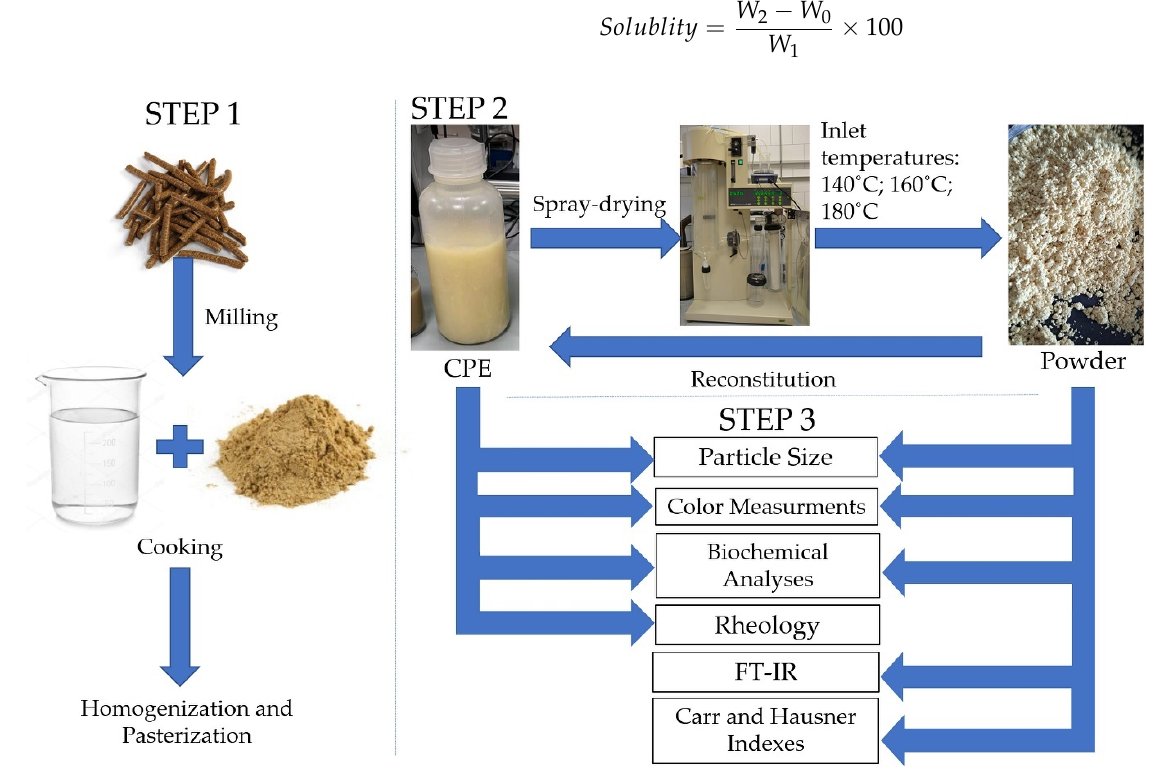
Figure 1. Scheme of research steps.